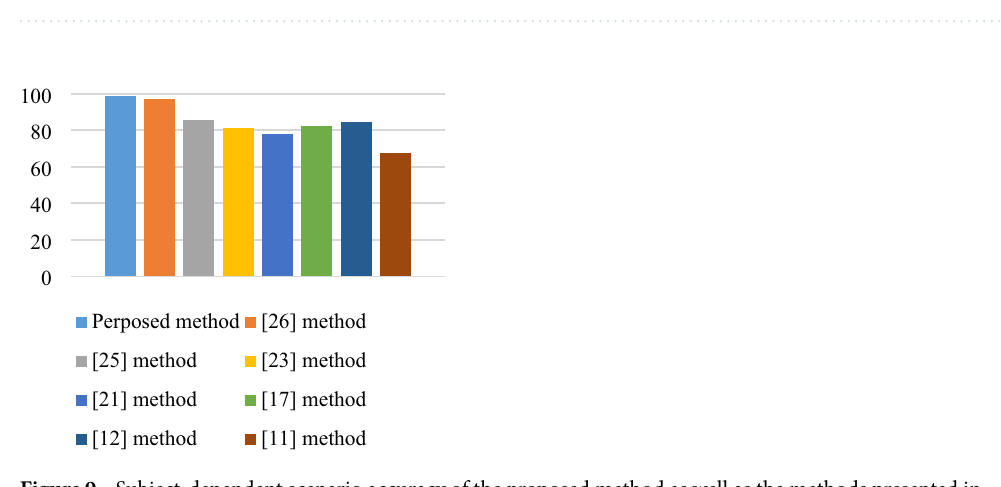
Figure 8. The procedure of musical stimulation to recognize emotions 43 , (Paper 43 was published in IEEE Access under a Creative Commons 4.0 license).